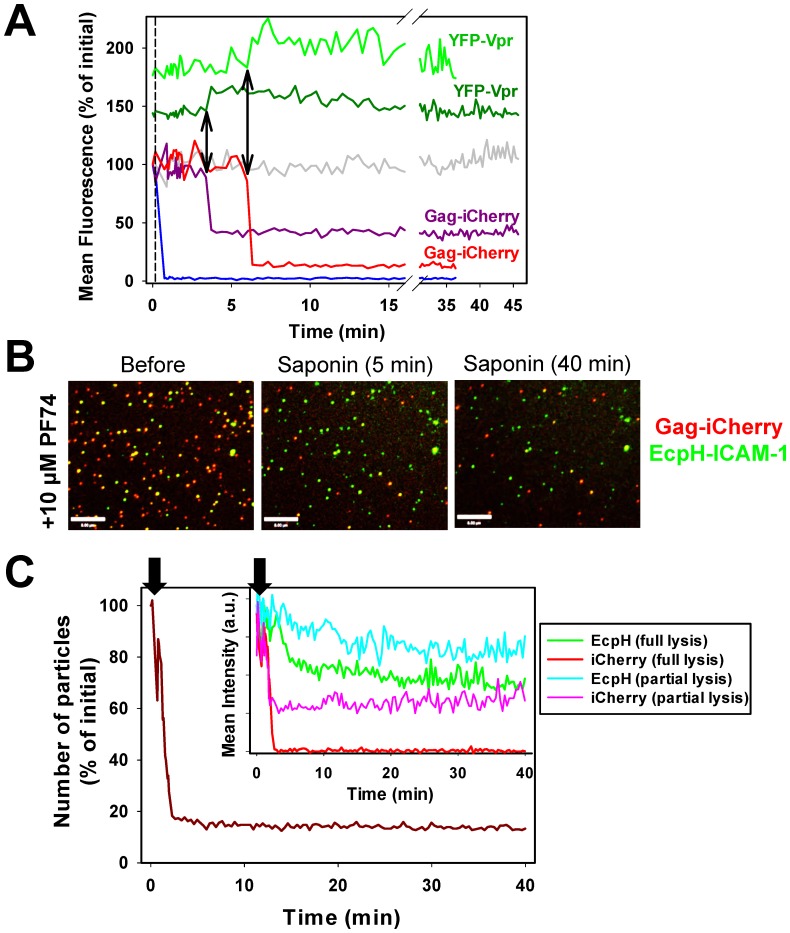
Free iCherry is released through a pore in the viral membrane, while the saponin-resistant content marker is retained under conditions expected to destabilize the capsid.(A) Content release from single pseudoviruses co-labeled with YFP-Vpr (capsid marker) and HIV-1 Gag-iCherry (content marker). Particles were adhered to a coverslip and imaged for 40 min at 37°C. Saponin was added after the third image frame (vertical dashed line). Normalized mean fluorescence intensities of iCherry and YFP from representative particles over time are plotted. Note the two distinct groupings in the graph where the YFP traces are shifted upward relative to the iCherry traces for visual clarity. The gray trace shows a particle that did not release its content marker and the blue trace corresponds to a typical particle that fully released iCherry upon addition of saponin before the imaging was resumed (the corresponding YFP traces are not shown for clarity). Red and dark pink lines show lytic events exhibiting different degrees of iCherry release; the corresponding YFP traces (green and dark green, respectively) are also shown. Double-arrows mark the onset of lysis and the corresponding increase in the YFP signal for the two representative partially lysed particles. Note that ∼10% of particles did not exhibit detectable changes in YFP fluorescence at the time of iCherry release (not shown). The lack of YFP dequenching is likely due to the slightly elevated membrane permeability, which equilibrates the pH across the viral membrane prior to addition of saponin. (B) Images of coverslip-immobilized pseudoviruses co-labeled with Gag-iCherry (red) and EcpH-ICAM-1 (green) before and after lysis with saponin. Saponin (0.1 mg/ml) was added together with 10 µM PF74 in phosphate buffer and the resulting lysis was imaged for 40 min at 37°C. Scale bar is 8 µm. (C) Single particle analysis of the lysis experiment illustrated in panel B. The number of Cherry-positive particles over time quickly decreased after adding saponin and PF74 (arrow) and stabilized after ∼3 min. Inset: Mean intensities of iCherry (red and pink traces) and EcpH (green and cyan traces) fluorescence as a function of time after addition of saponin (arrow) are plotted for representative full iCherry release (red) and partial release (pink) events. A slow decrease of the EcpH-ICAM-1 signal over time in panels B and C is likely related to disruption of the viral membrane upon prolonged exposure to saponin.